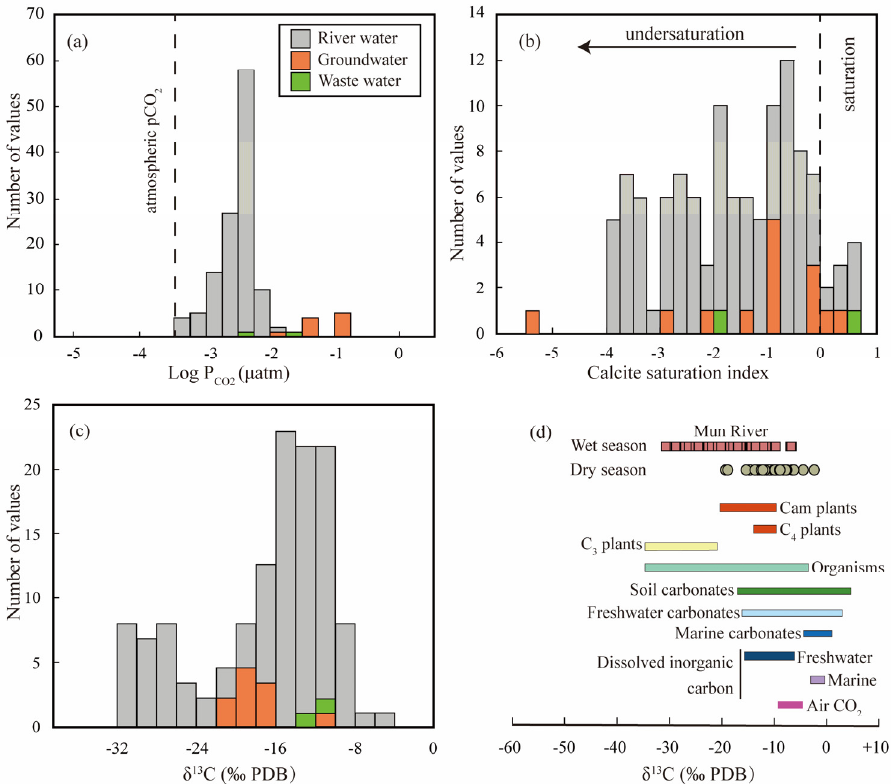
Figure 3. Values of p CO 2 ( a ), calcite saturation indexes ( b ), and δ 13 C DIC ( c ) in the study water samples. ( d ) Numerical range of δ 13 C in different carbon reservoirs, data are derived from Schulte , et al. [72].